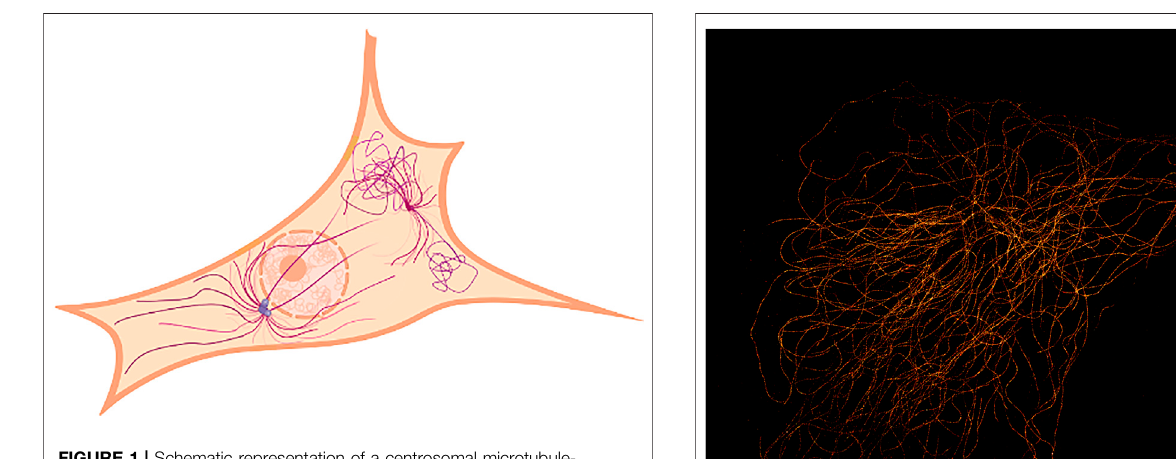
FIGURE 1 | Schematic representation of a centrosomal microtubule- organizing center tied to the nucleus and the microtubule organization proximal to the edge of a cell.